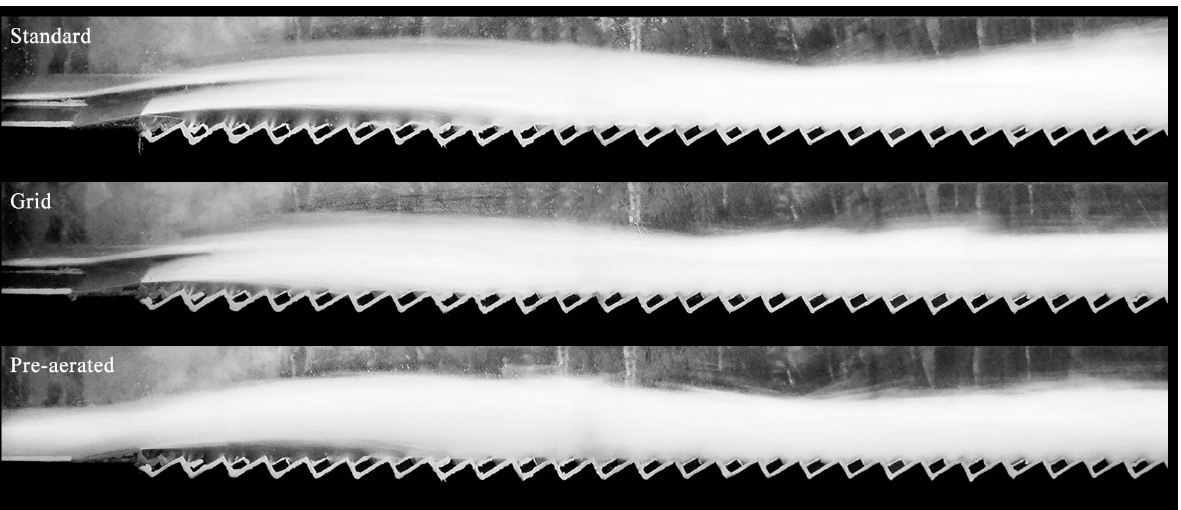
Figure 13. Visual comparison of the standard, grid and pre-aerated tests (respectively tests 58, 65 and 68) for F o = 7.3–7.5. Table 2. Jet characteristics of standard, grid and pre-aerated aerator tests.